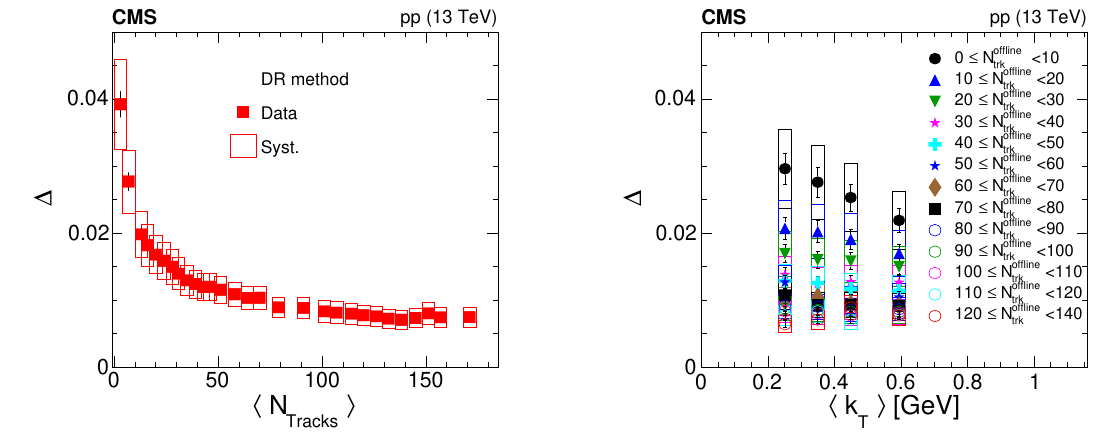
Figure 11 . The depth of the anticorrelation (cid:1) is shown as a function of multiplicity (left) for k -integrated values. The (cid:12)t parameter (cid:1) is also shown in (cid:12)ner bins of N T statistical uncertainties are represented by the error bars, while the systematic ones are represented by the open